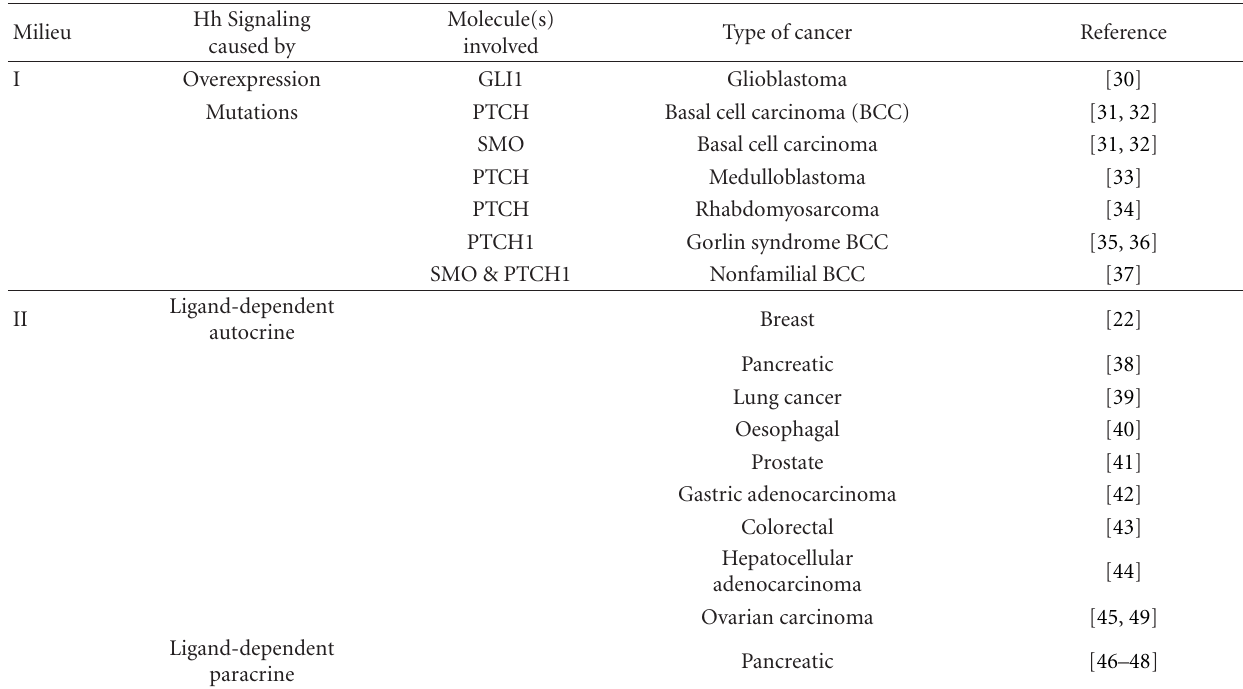
Table 1: Cancers with aberrant activation of Hh